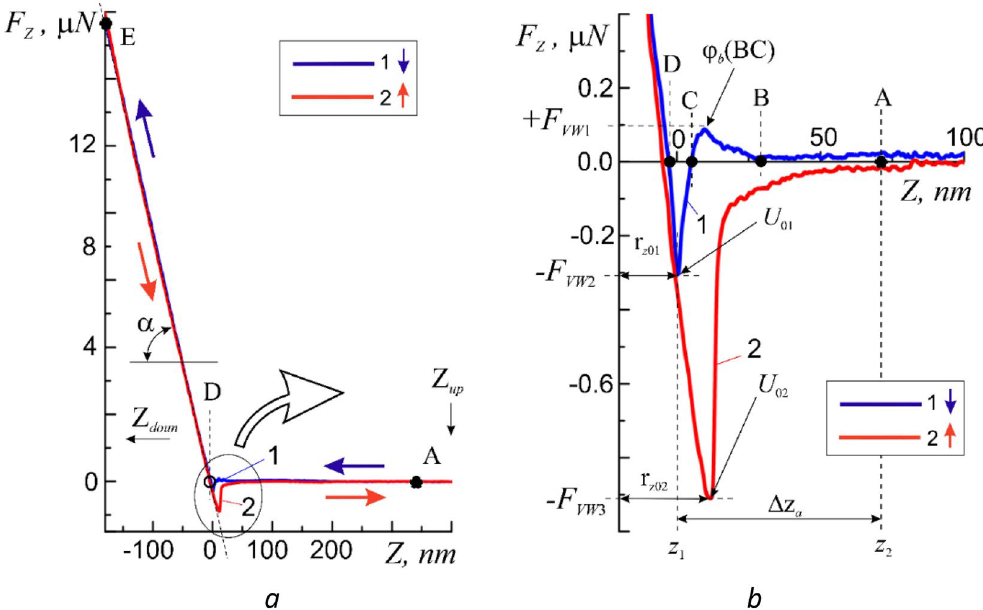
Figure 3. Approach 1 and withdrawal 2 curves (inset) obtained on the epitaxial silicon surface ( a ), and a more detailed image of the same curves in the region of the adsorption layer ( b